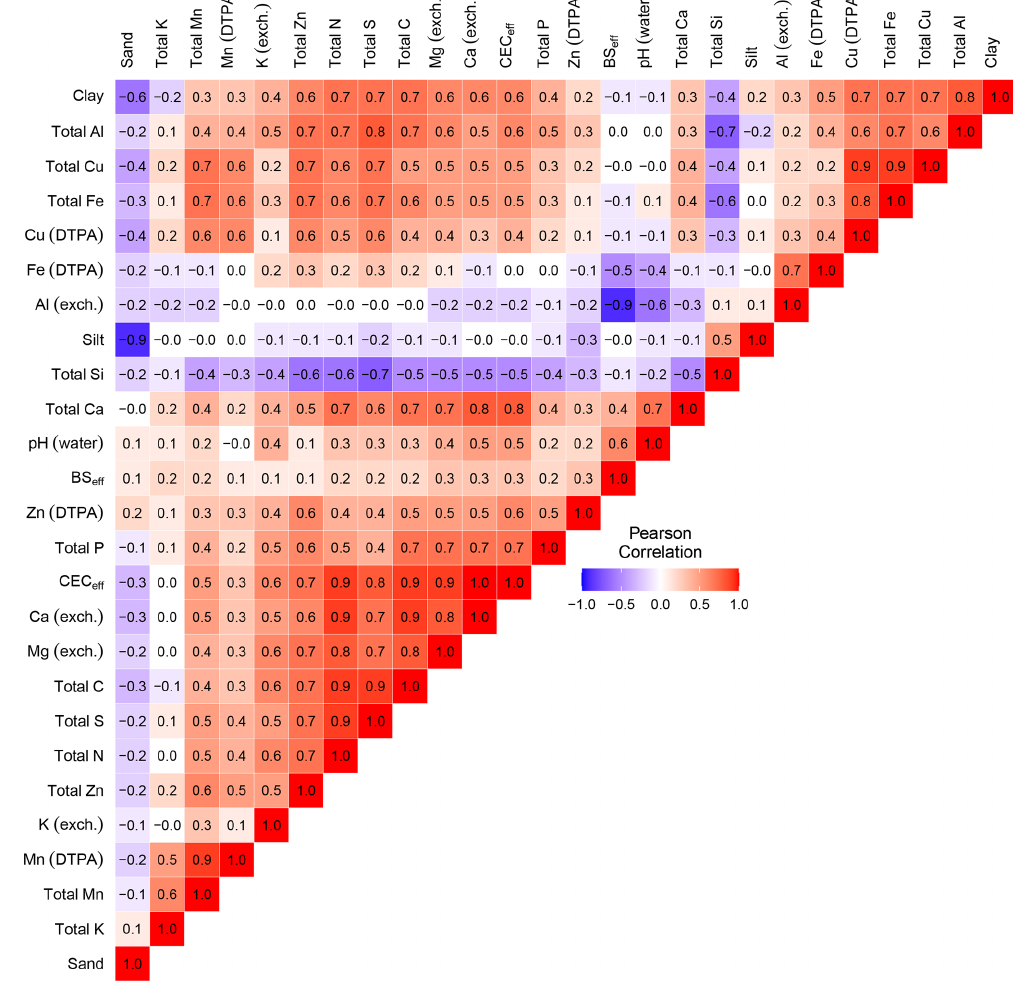
Figure 2. Correlation matrix of soil properties measured on each of the 20 soils sampled from individual yam fields per landscape and 14 additional agricultural soils received from the World Agroforestry Center ( n = 94; see Fig. 1 for further details and abbreviated chemical properties). Pearson correlation coefficients ( r ) were rounded to one decimal